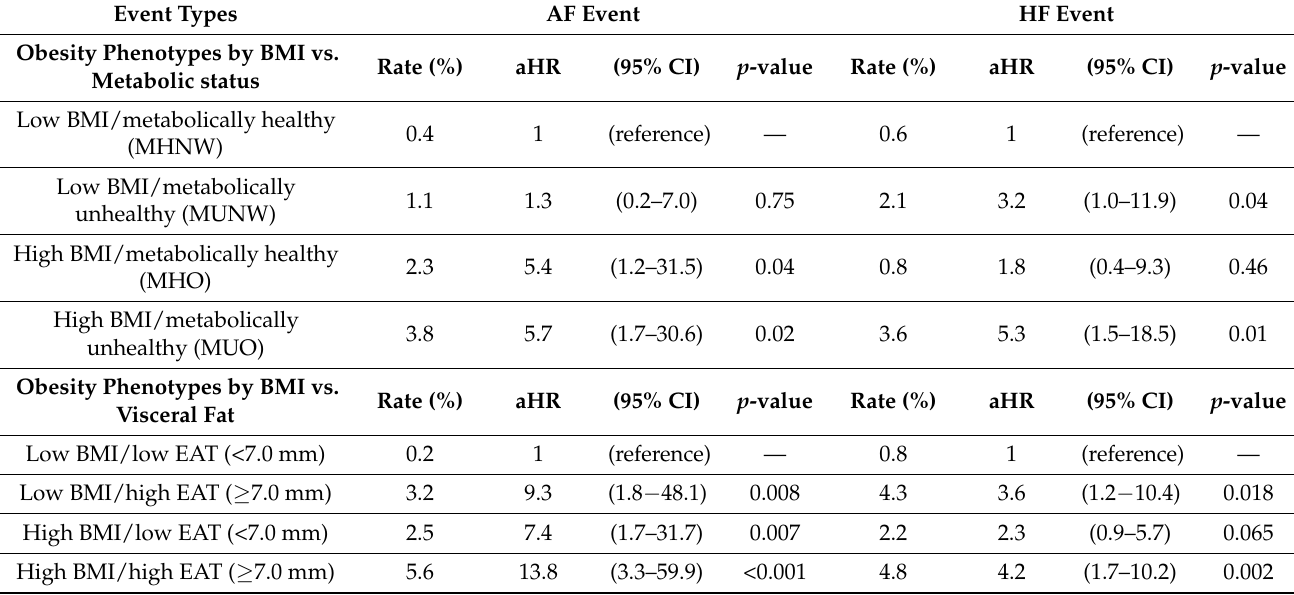
Abbreviations same as Table 1. aHR, adjusted hazard ratio. Models adjusted for clinical covariates including age, sex, systolic pressure, pulse rate, fasting glucose, triglyceride, HDL-c, eGFR plus LAV(max) for AF; and adjusted for clinical covariates plus LVM for HF. There were 71 AF events and 75 HF events with data from both categorizations